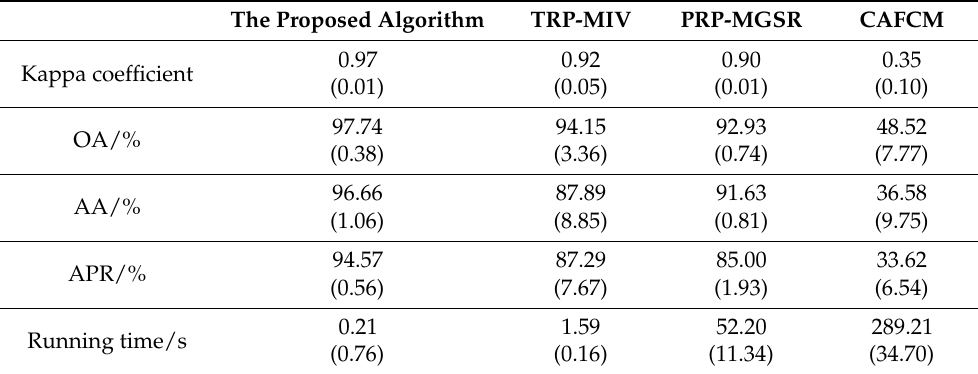
Table 5. Accuracy evaluation of classification results for the Chikusei image. (The values in brackets are the variance of 100 trials, and those not in are the mean).